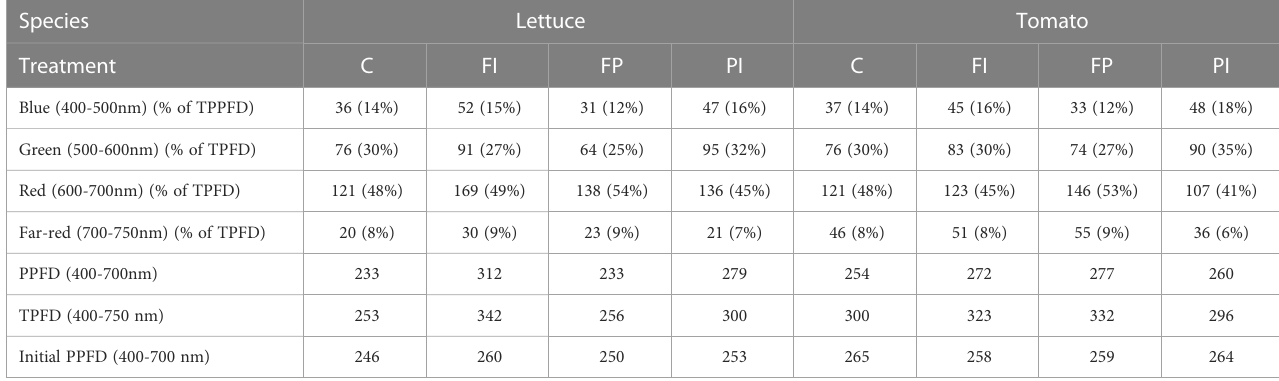
TABLE 1 Light intensity and spectra under OSC fi